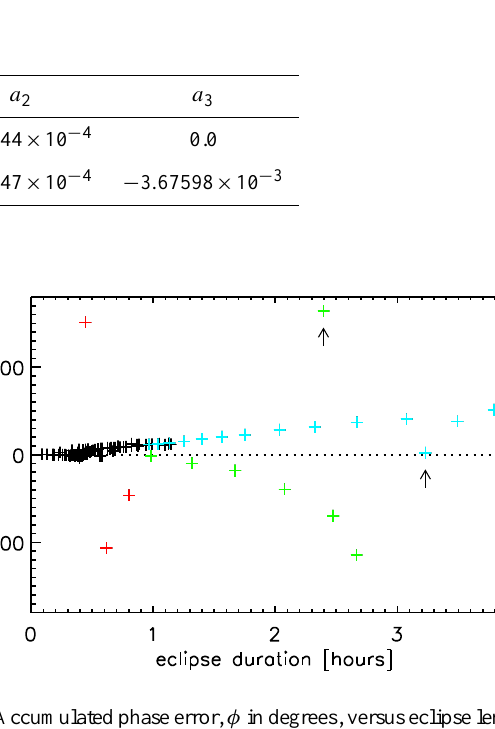
Fig. 3. Accumulated phase error, φ in degrees, versus eclipse length for the THEMIS B eclipses between March 2008 and July 2009. Black: all eclipses up to about 1h duration for 2008 and 2009, blue: long eclipses in 2009, green: long eclipses in 2008, red: bad results due to manoeuvres. The arrows point to the long eclipses with very long stay in